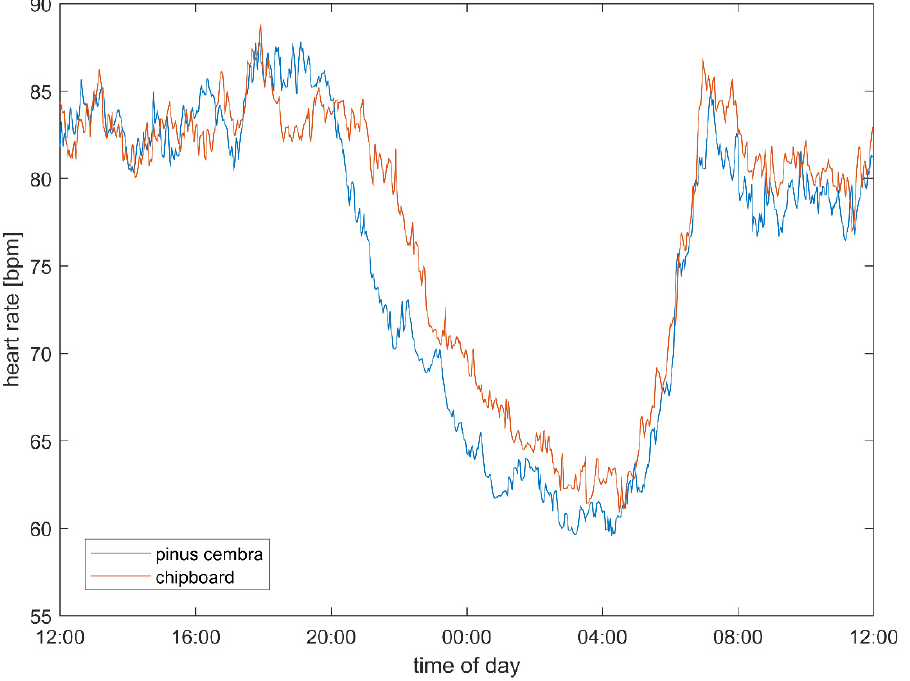
Figure 3. Heart rate over 24 h when the subjects slept in the stone pine wood beds (blue) or in the chipboard beds (red). Each curve represents the average of nearly 90 days of measurements for 15 subjects. The strongest difference in the heart rate was found during the first phase of sleep.